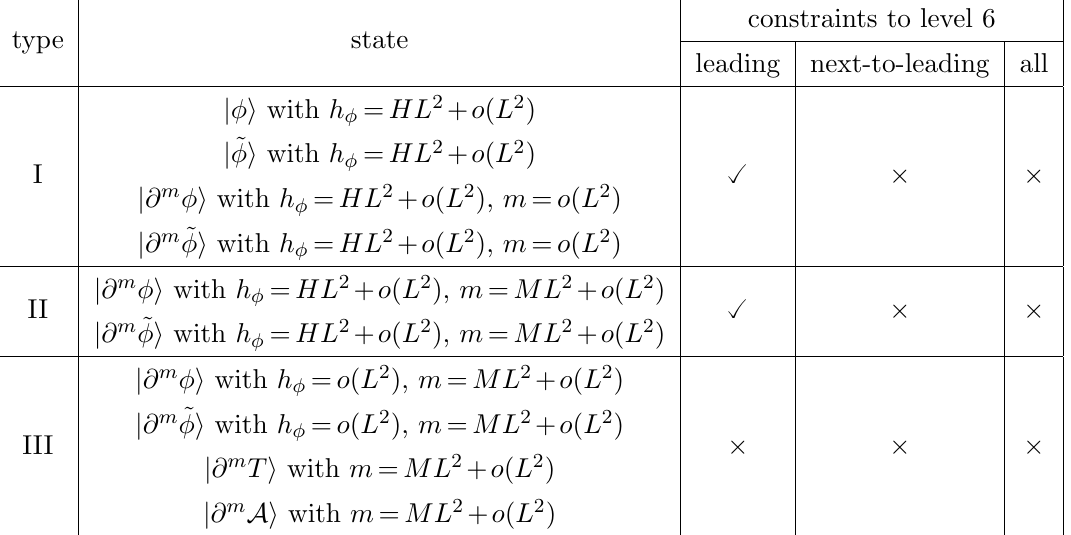
Table 1 . The three types primary and descendant states we consider in this section, and whether they satisfy the ETH constraints derived from EE, relative entropy, and the expectation values of KdV charges up to level 6 of the holomorphic sector of the vacuum conformal family. In the 2nd column we have de(cid:12)nitions H = c + O ( c 0 ), M = O ( c 0 ), with the positive constants H and M 24 (cid:12) 2 being of O ( L 0 ). Note that for M = O ( c ) all the leading order and next-to-leading order constraints are violated. The 3rd, 4th, and 5th columns all apply to the constraints derived from EE, relative entropy, and the expectation values of KdV charges. We mark